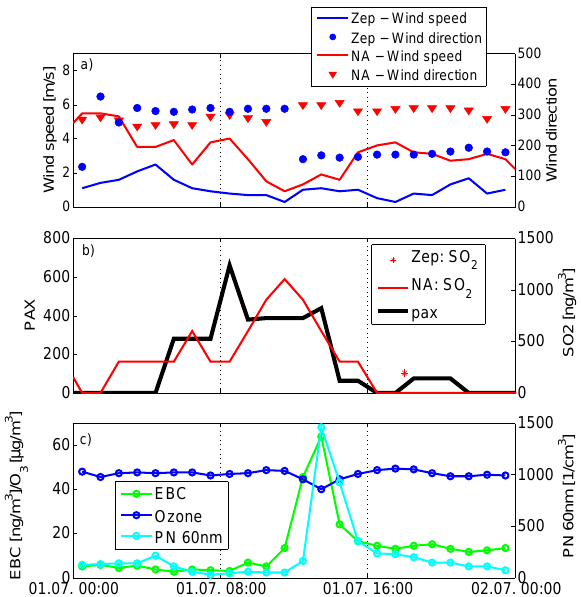
Fig. 3. Wind and air chemistry measurements at Zeppelin and in Ny Ålesund during 1st July 2009. The top panel (a) shows hourly mea- surements of wind speed (ms − 1 ) and wind direction at Zeppelin (blue) and in Ny Ålesund (red). In the middle panel (b) , the black line indicates the number of passengers in the harbor (PAX), the red line shows the continuous SO 2 measurements in Ny Ålesund, and the red asterisk shows the daily average SO 2 concentration at Zep- pelin from filter sample measurements. In the lower panel (c) , the green line is the EBC concentration, the light blue line the PN60 concentration, and the dark blue line shows the ozone concentra- tion, all measured at